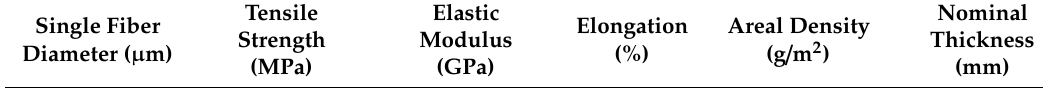
Table 4. Technical parameters of the unidirectional basalt fiber sheets.